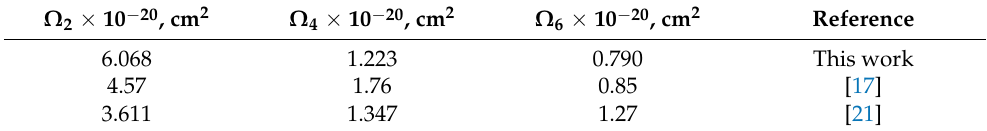
Table 2. The J–O intensity parameters Ω 2,4,6 of Er 3+ .